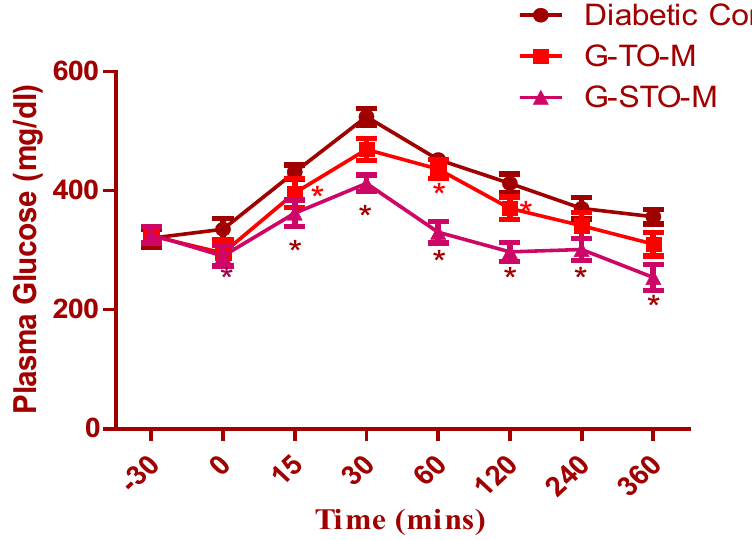
Figure 9. Results of oral glucose tolerance test (* p < 0.05).